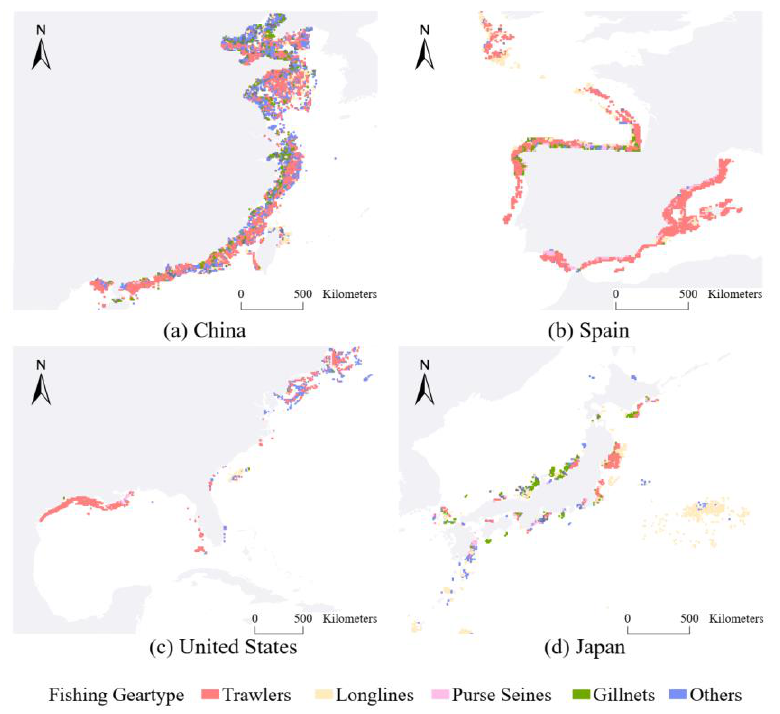
Figure 13. Lockdown and non-lockdown countries’ fishing gear spatial distribution from March to